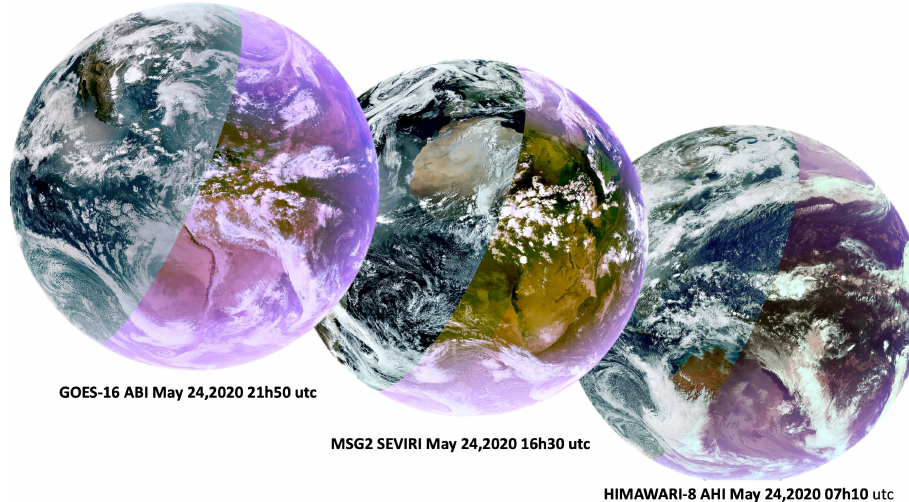
Figure 4. Examples of day and night RGB composites for GOES-16 ABI ( left ), MSG2 SEVIRI ( middle ), and Himawari-8 AHI ( right ) data for the same day 24 May 2020.